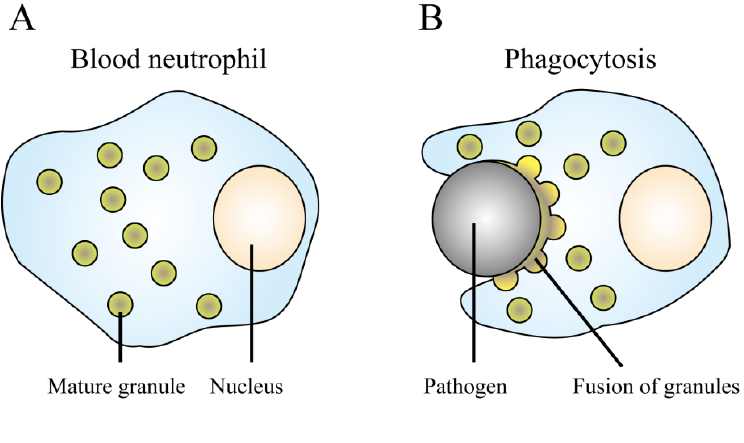
Figure 4. Phagocytosis of pathogenic cells by neutrophils. ( A ) Synthesis of defensins in neutrophils. α -Defensins are proteolytically processed to the mature form and then packaged into azurophil granules. ( B ) Phagocytosis of pathogenic cells. When a mature neutrophil ingests a pathogenic cell, it simultaneously evokes the fusion of azurophil granules and the phagosome, and the α -defensins then exert antimicrobial activity in the limited